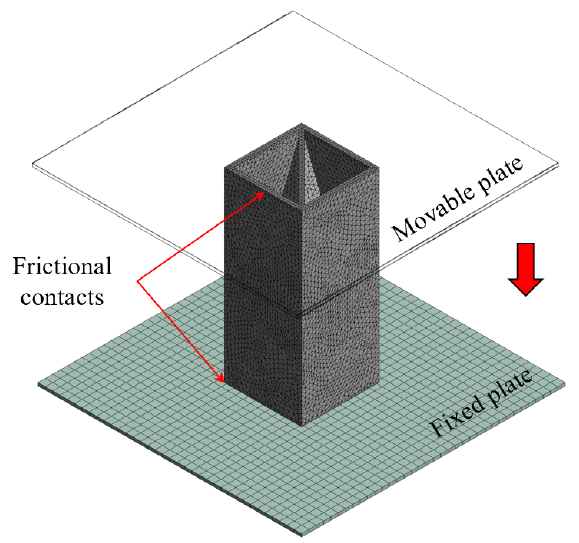
Figure 5. FE model of novel cell under axial load.